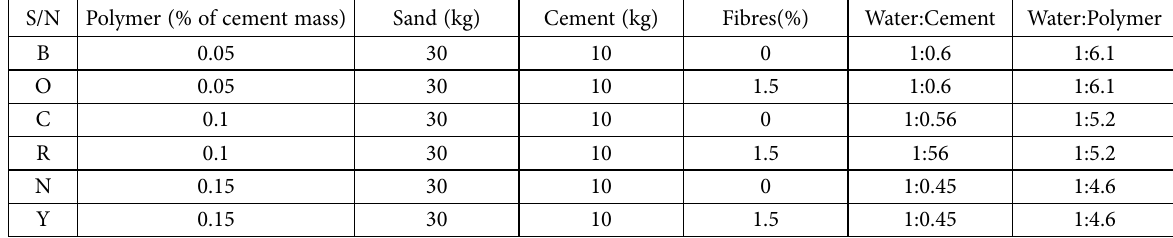
Table 1. Experimental mix design (source: created by the author Akinyemi 2017) S/N Polymer (% of cement mass) Sand (kg) Cement (kg) Fibres(%)